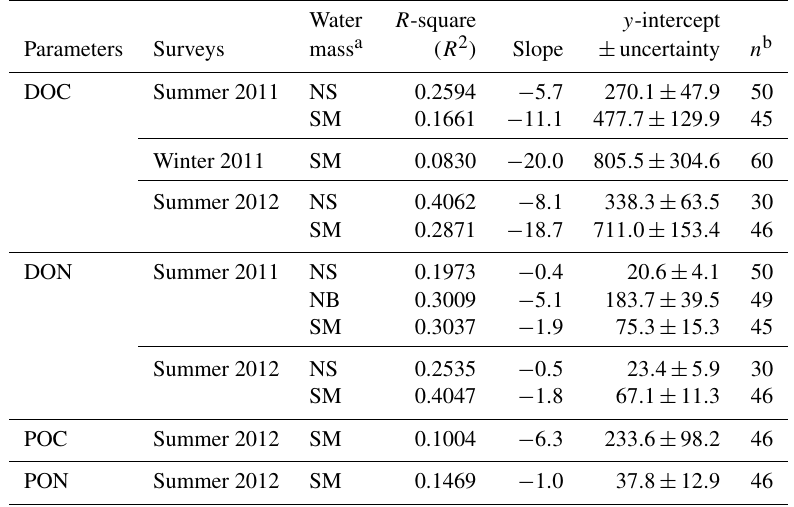
Table 4. Regression analysis of DOC, DON, POC and PON with salinity in each water mass. Note that only significant correlations (at the 0.05 confidence level) are